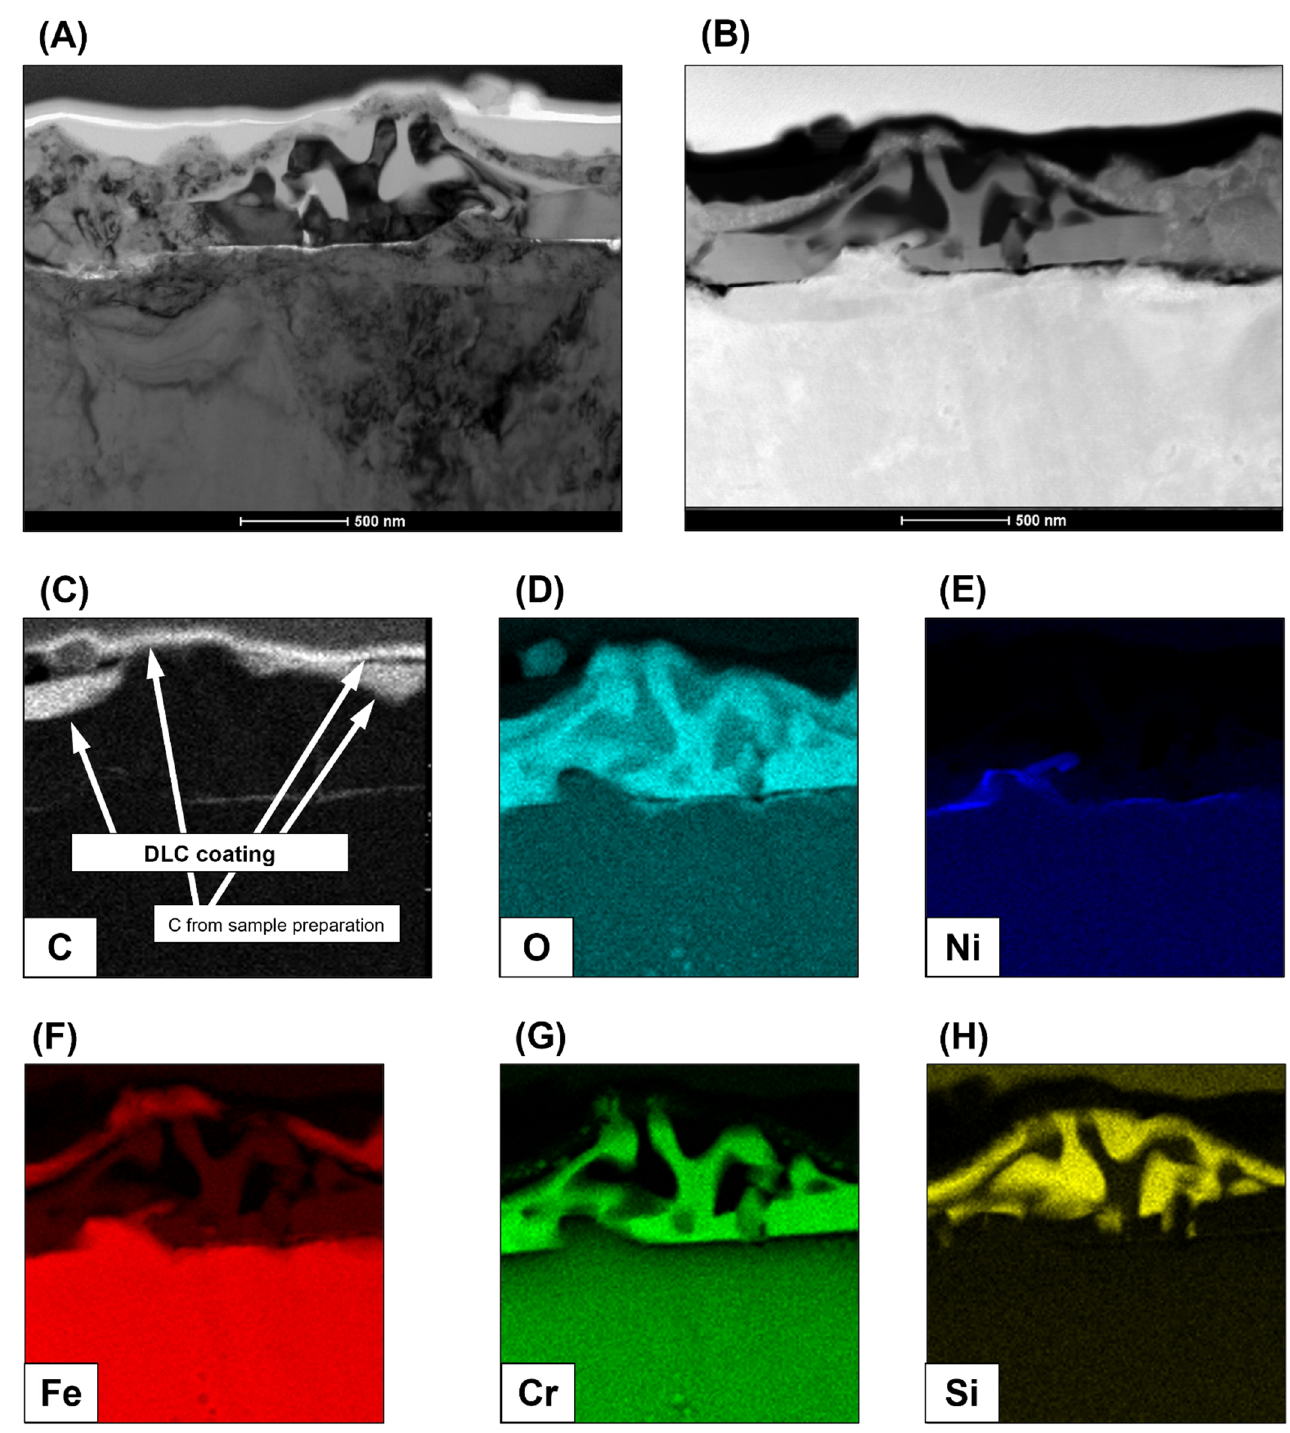
Figure 16. TEM/BF ( A ) and STEM/HAADF ( B ) images of the DLC coating and corresponding maps presenting the distribution of C ( C ), O ( D ), Ni ( E ), Fe ( F ), Cr ( G ) and S ( H ).